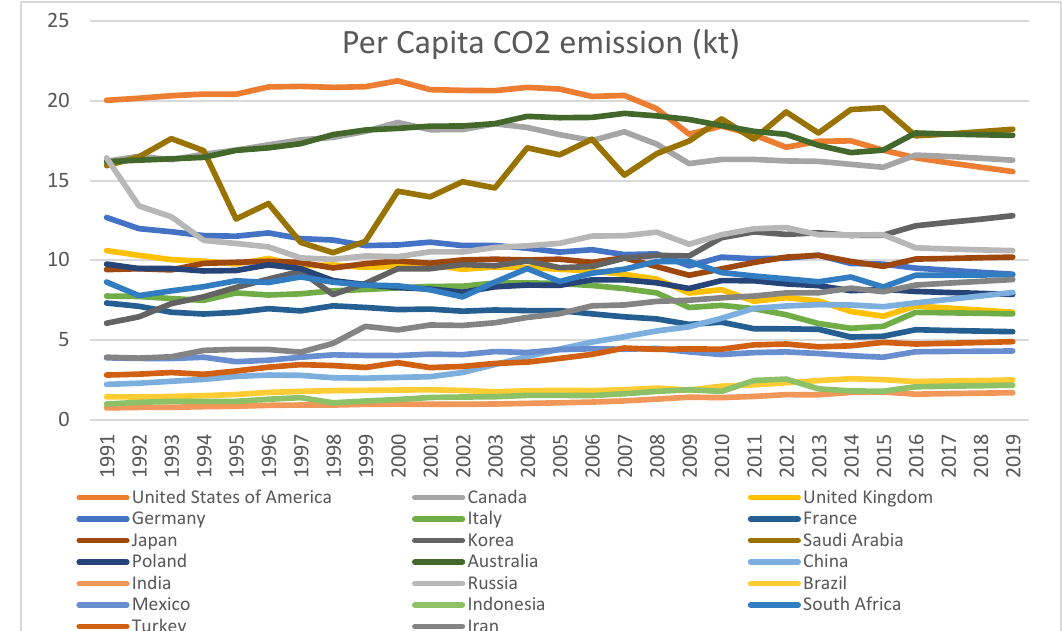
Figure 1. Per Capita CO 2 emission (kt). Source: Author’s own derivations.